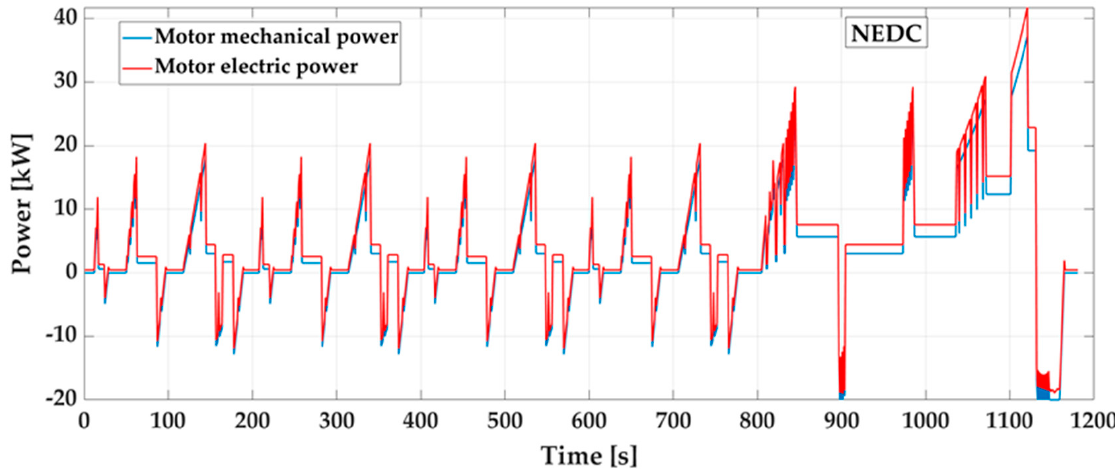
Figure 8. Motor electric and mechanical power vs. time for NEDC in the case of a single speed gearbox.